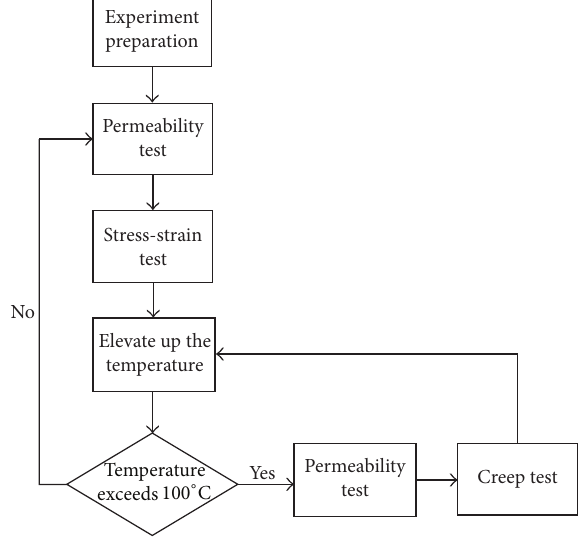
Figure 4: Flow chart diagram of the test